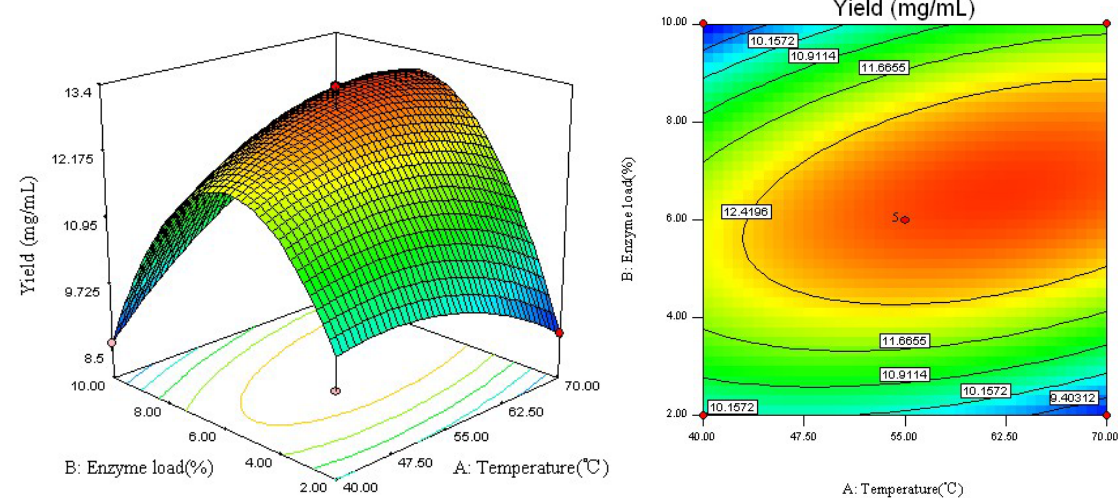
Figure 2. Response surface plot and contour plot of reaction temperature and enzyme load.